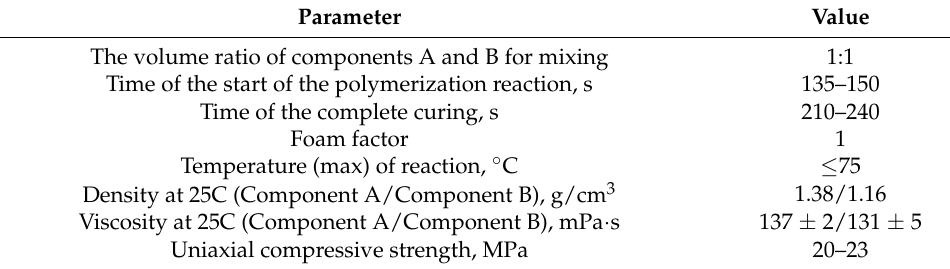
Table 2. Properties of two-component silicate resin [39].